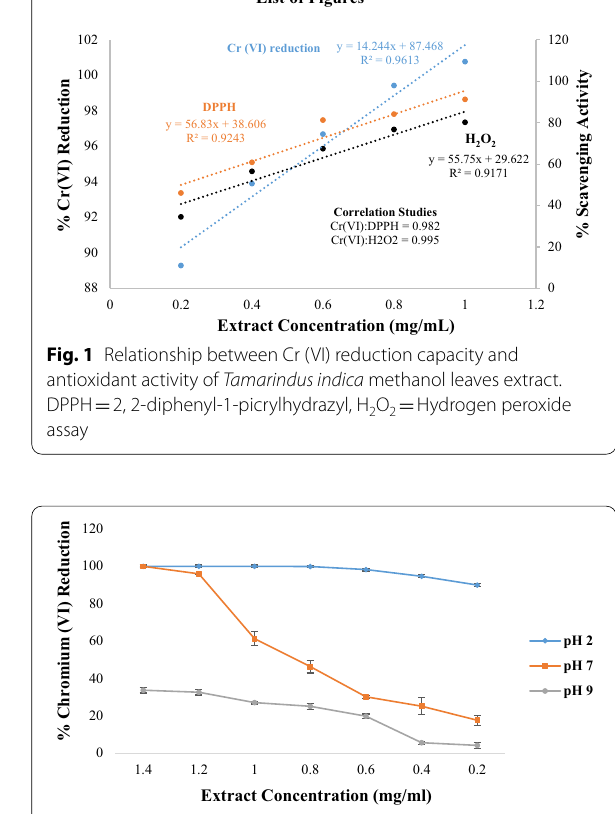
27 °C, time 30 min, = =